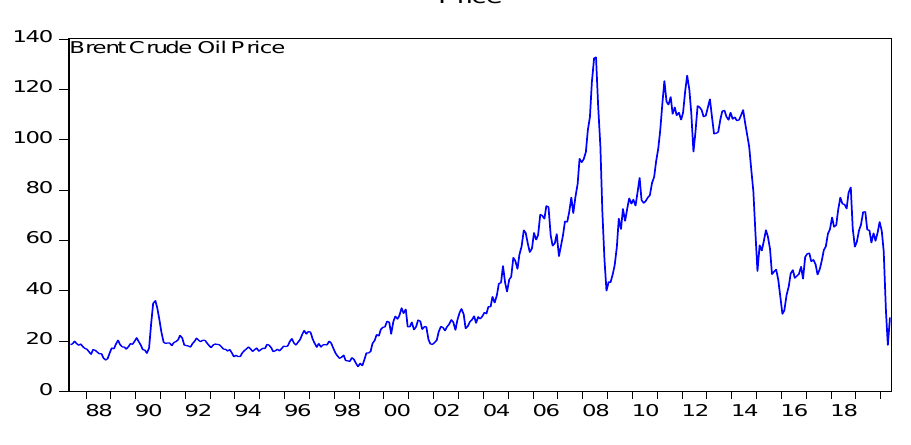
Figure 1. Plot of Brent crude oil price per barrel.